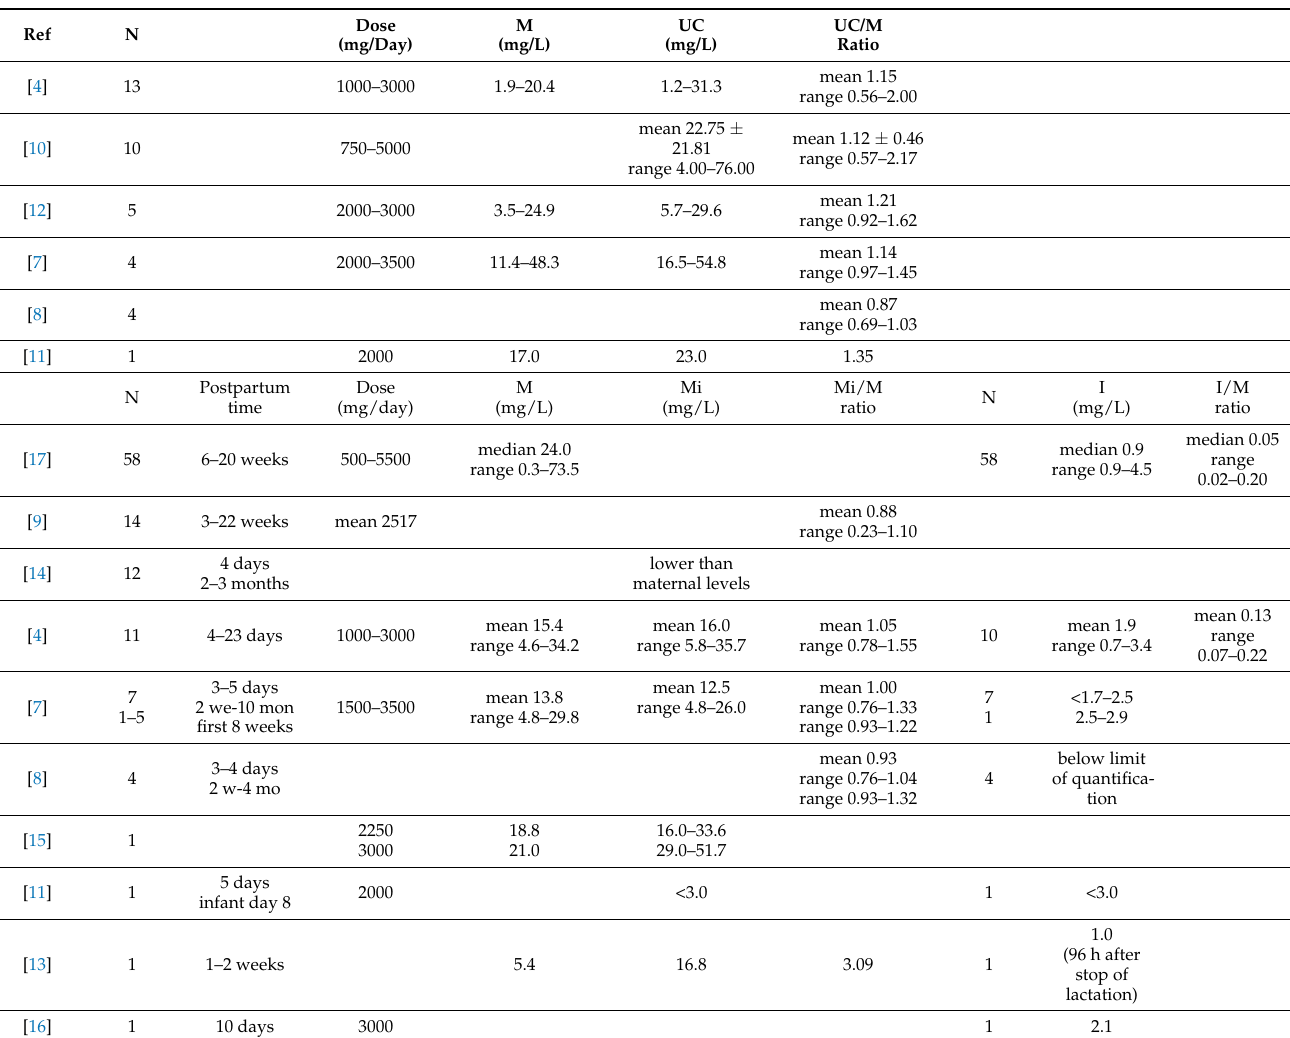
Table 5. Review of literature (Ref-reference, N-number, M-maternal, UC-umbilical cord, Mi-milk and I-infant concentrations of levetiracetam)